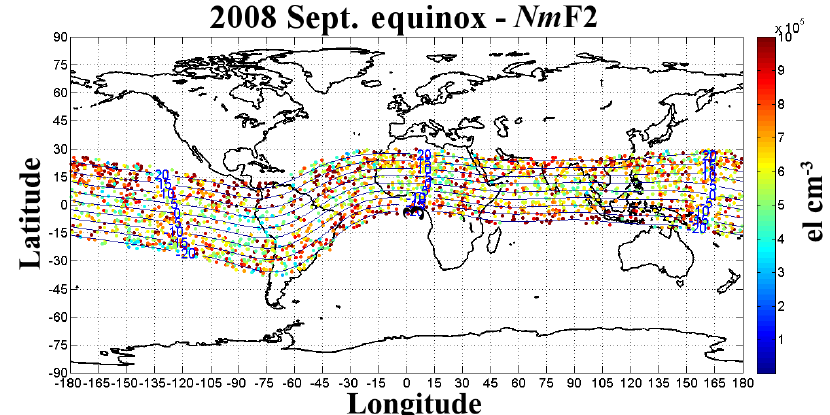
Figure 1. Magnetic latitude interval of observations. Illustration of the ionospheric data used in the present study, which includes observations in the region ± 20 ◦ around the magnetic equator. The example above is the Nm F2 data taken during a time interval between 12:00 and